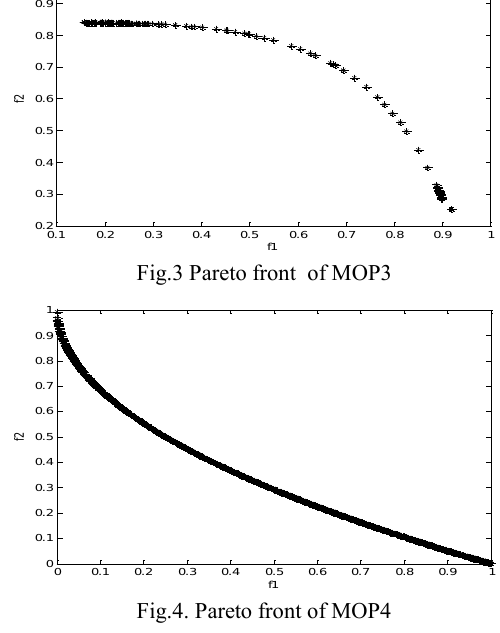
Fig.2 Pareto front of MOP2